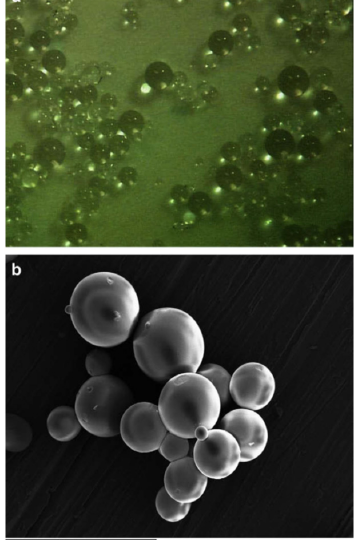
Figure 15. Adapted with permission from S. Radin et al. [83]. Copyright 2009 Elsevier. License number 5318830763811. ( a ) and ( b ) are optical and SEM micrographs of emulsified acid-base catalyzed silica microspheres.